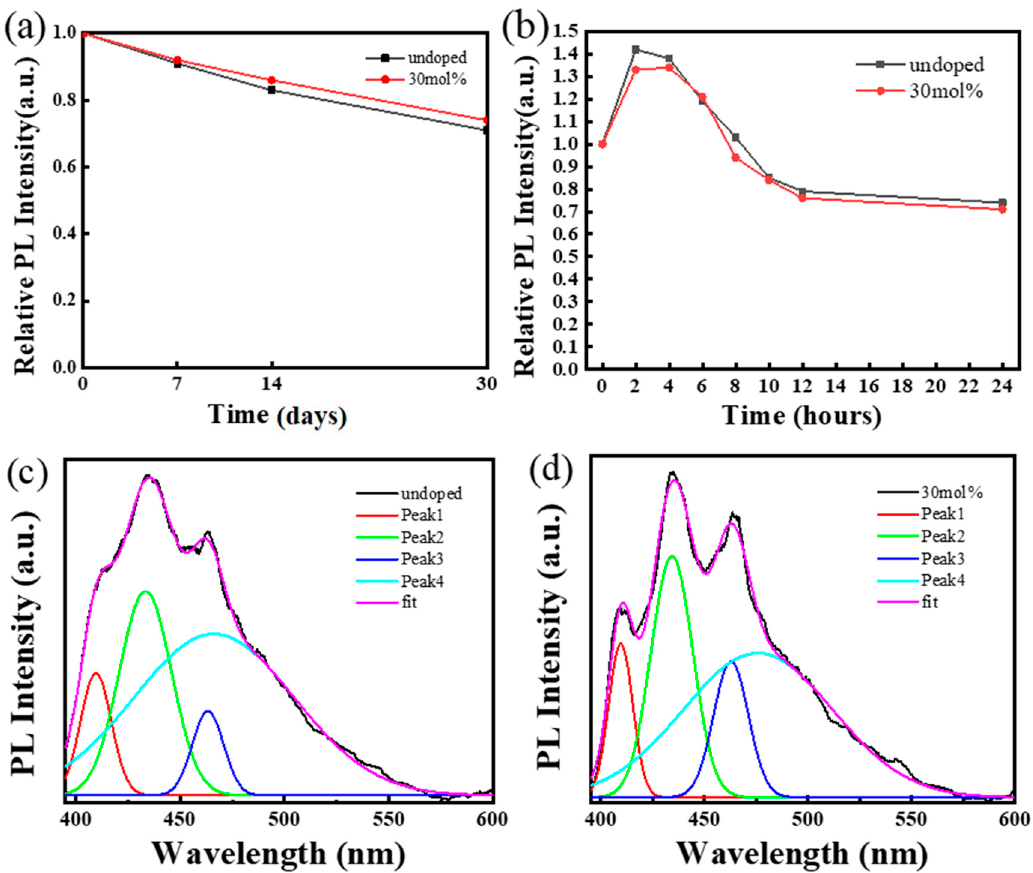
Figure 4. ( a ) Air stability of samples under non-dark conditions, results normalized; ( b ) water stability experiments of Cs 3 Bi 2 Cl 9 and Cs 3 Bi 2 Cl 9 : Ce 30% QDs and the relative PL intensities of samples in water as a function of time, results normalized; ( c ) low-temperature (150 K) photoluminescence spectrum and related fitting peaks of Cs 3 Bi 2 Cl 9 QDs; ( d ) low-temperature (150 K) photoluminescence spectrum and related fitting peaks of Cs 3 Bi 2 Cl 9 : Ce 30% QDs.